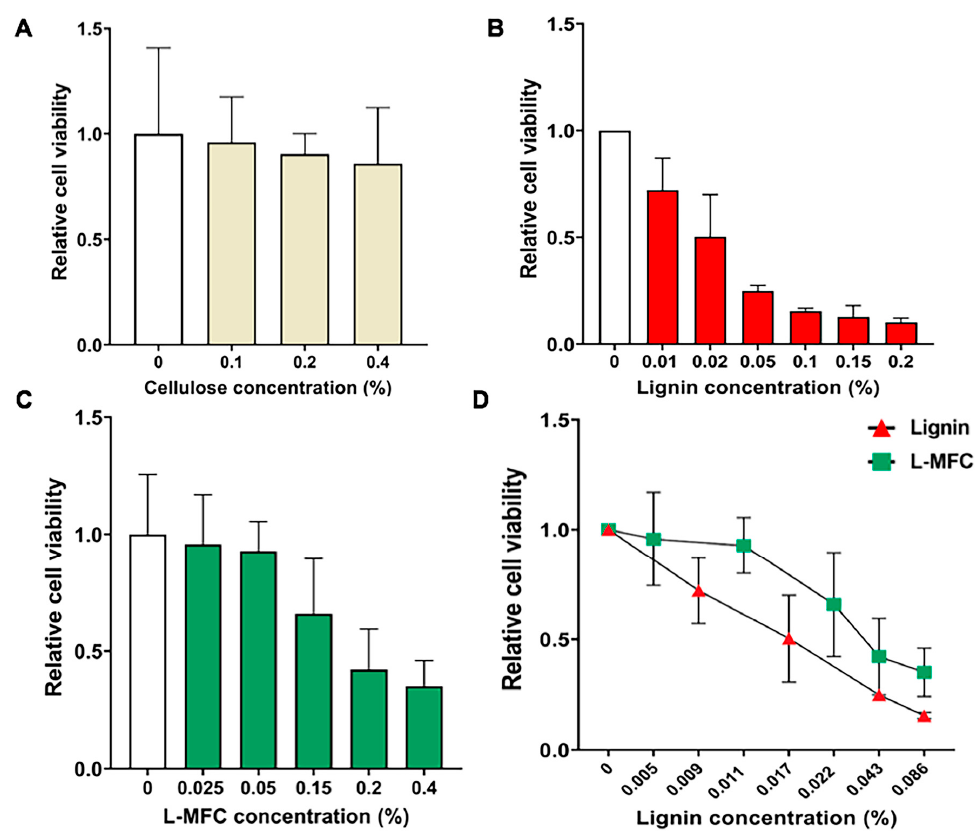
Figure 3. Toxicity of cellulose, L-MFC, and lignin in H460 cells. ( A ) WST assay results with cellulose at concentrations 0, 0.1, 0.2, and 0.4%. Error bars show s. d. (n = 12 biological replicates). ( B ) WST assay results with lignin in increasing amounts. Error bars show s. d. (n = 12). ( C ) WST assay results with L-MFC. Error bars show s. d. (n = 12). ( D ) Comparison between pure lignin and lignin contained in L-MFC for cytotoxicity. Error bars show s. d. (n = 3). Table 4. LC 50 value of L-MFC in H460 cells.